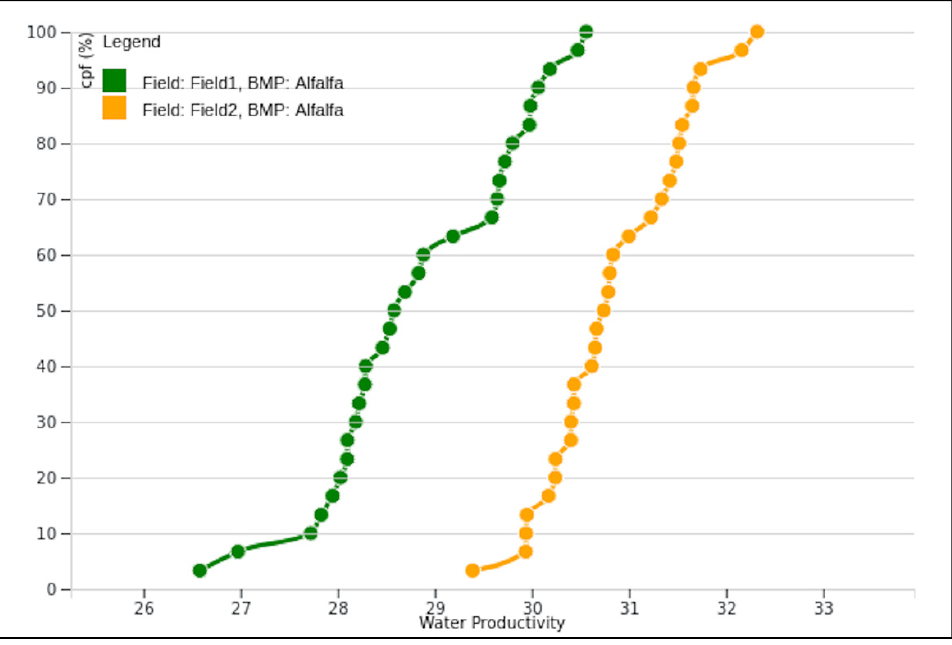
Figure 9. Crude Protein for Field 1 (near Tulare, California) and Field 2 (near Davis, California). 4. Discussion This simulation results of field 2, which has better water productivity and forage quality, were validated using 2020 observation data (UC ANR Alfalfa cultivar trial [62]). Table 9 shows the mean yield (dry, tons/acre) values of 28 varieties for each cutting date from the 2020 yield data of UC ANR Alfalfa cultivar trial. The mean yield was calculated as 3641.16 (kg/ha) from seven cutting events. The total yield was 11.34 (tons/acre) (25,420.88 (kg/ha)). The total yield in the report (11.34 (tons/acre)) [62] is slightly different from the value (11.37 (tons/acre)) calculated using cutting values in Table 9 due to round off errors. The maximum total yield was found to be 12.59 (tons/acre) (28,223.00 (kg/ha))